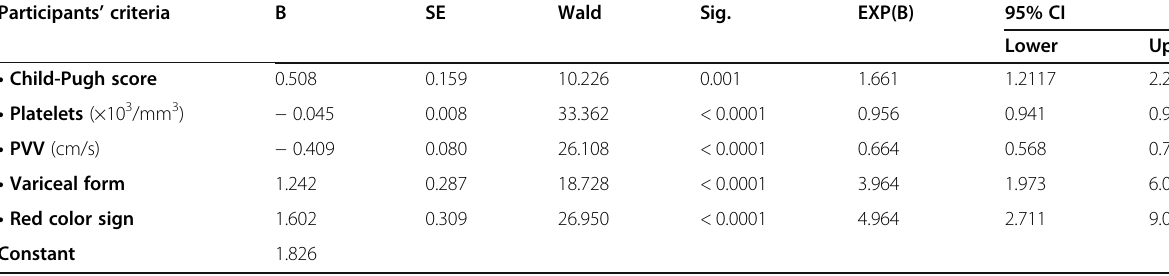
Table 3 Multivariable regression analysis for the evaluated